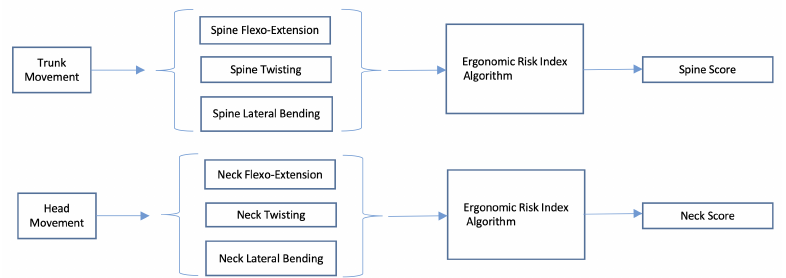
Figure 4. Spine and neck scores are obtained independently from the corresponding information. The same algorithm is applied for both segments. Both scores are entered in a look-up table to obtain an overall score for head and trunk as in the RULA approach.